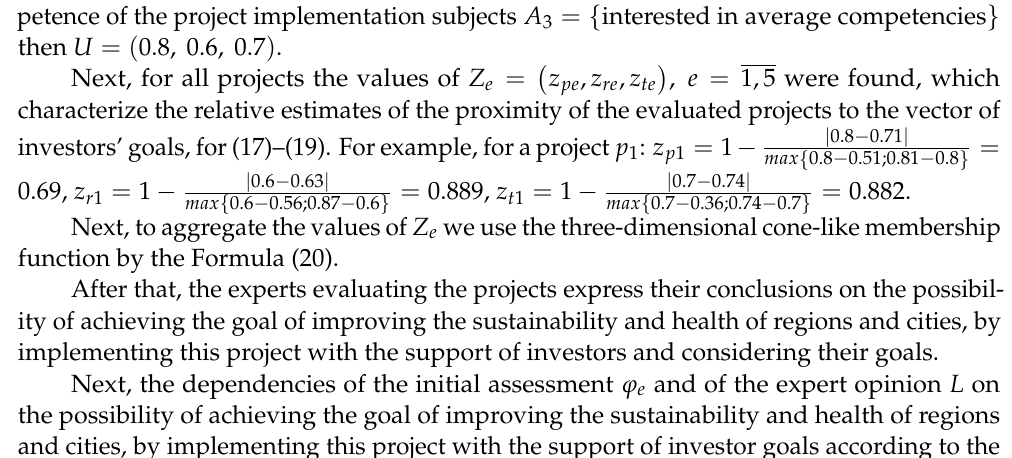
Table 4. Calculation results and expert opinions L . Evaluation z p relative to the goal G P 0.690 0.379 0.897 0 0.966 Evaluation z r relative to the goal G R 0.889 0 0.185 0.926 0.852 Evaluation z t relative to the goal G T 0.882 0.176 0.471 0.882 0 Output estimates ϕ e 0.883 0.521 0.674 Expert opinions L L 1 L 4 Aggregate normalized estimates f ( ϕ e ) 0.969 0.443 0.611 0.903